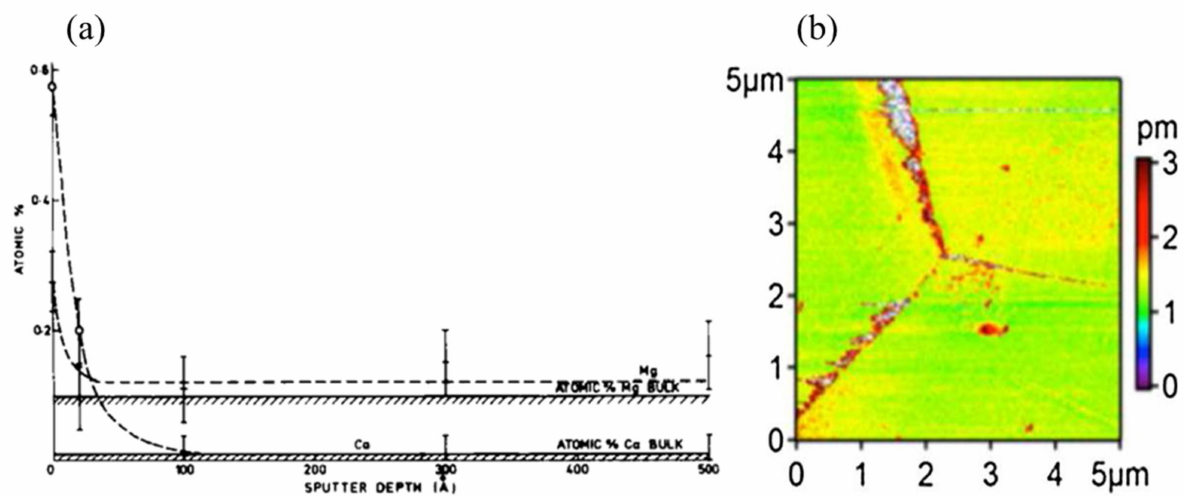
Figure 6. ( a ) concentration of Mg and Ca (at%) as a function of distance (nm) from the GB [70], ( b ) Electrochemical strain microscopy (EMS) detecting space charge in a polycrystalline Sm-doped ceria. ESM map of response magnitude for ± 3V perturbation, revealing increased response in the GB [71]. Figure 6a reprinted from Journal of the American Ceramic Society, 57, Taylor, R.I., Coad, J.P. and Brook, R.J., Grain Boundary Segregation in Al 2 O 3 , 539–540, Copyright (2006), with permission from John Wiley and Sons. Figure 6b reprinted from Progress in Materials Science, 89, Giuliano Gregori, Rotraut Merkle, Joachim Maier, Ion conduction and redistribution at grain boundaries in oxide systems, 252–305, Copyright (2017), with permission from